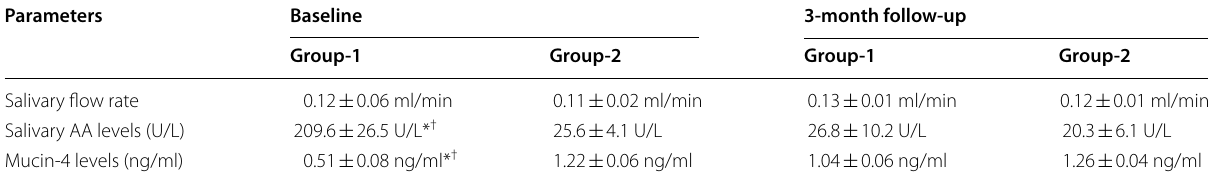
*Compared with Group-2 at baseline ( P < 0.01) using the paired t test † Compared with Groups-1 ( P < 0.01) and 2 ( P < 0.01) at 3-month follow-up using the paired t test and the Bonferroni Post-hoc